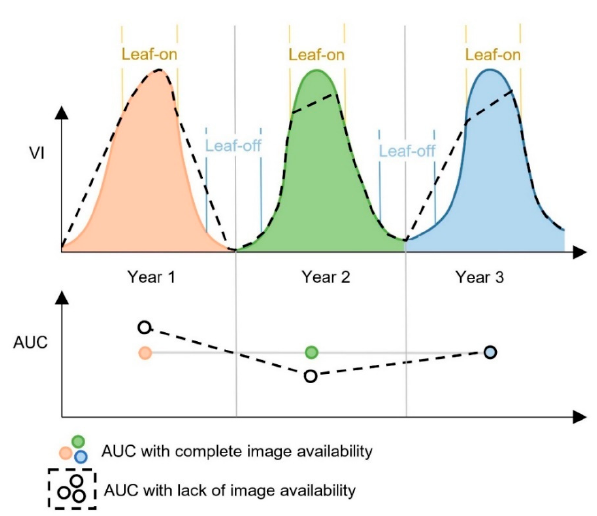
Figure 4. Method followed to mitigate differences in AUC due to availability or lack of availability of images. Year 1 (lack of images in winter), Year 2 (lack of images in summer) and Year 3 (lack of images in both summer and winter).